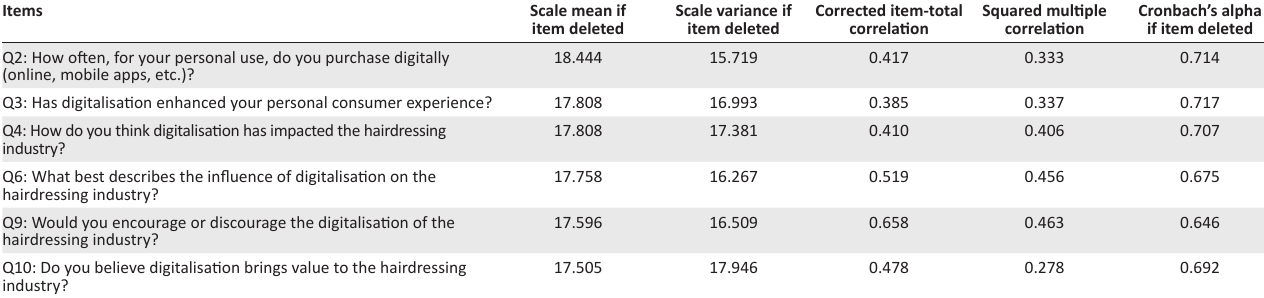
TABLE 5a: Iterative reliability analysis of questionnaire items. Items